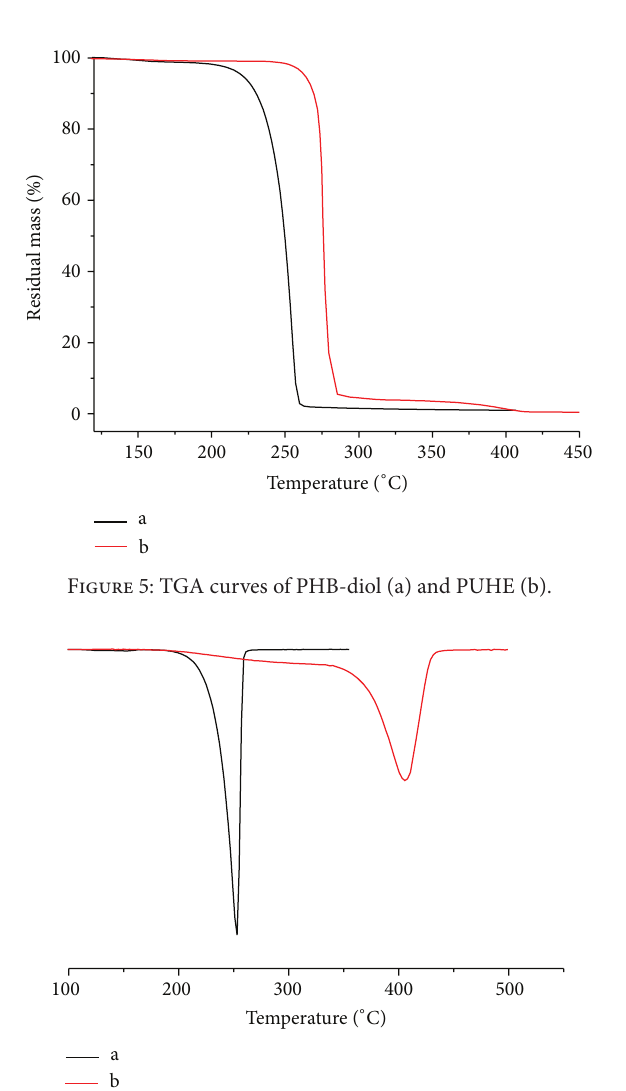
Figure 6: DTG curves of PHB-diol (a) and PUHE (b).